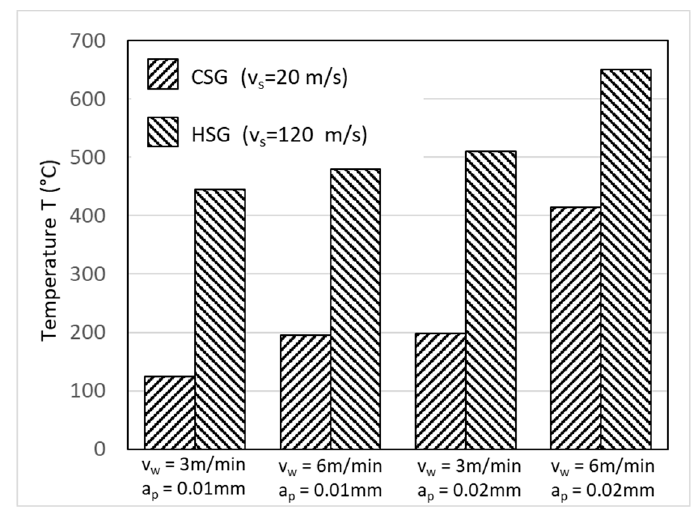
Figure 6. Effects of grinding parameter in high (HSG) and conventional (CSG) speed grinding on grinding temperature [55].